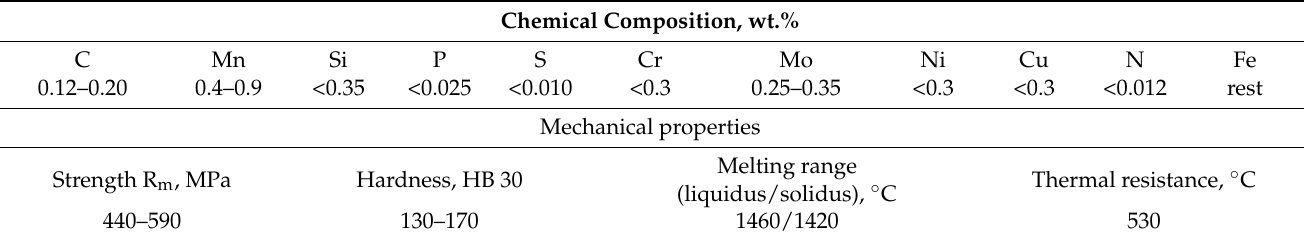
Table 1. Chemical composition and physical properties of 16Mo3 (1.5415) low-alloy boiler steel according to EN 10273. Chemical Composition, wt.%